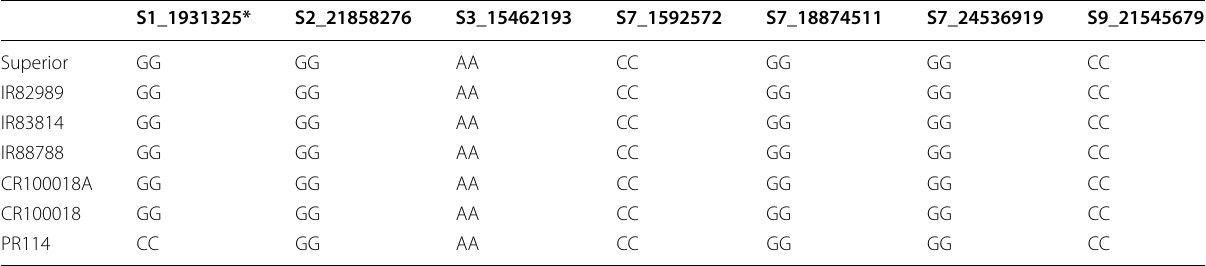
Table 7 The list of O. rufipogon accessions possessing combination of superior alleles at significant SNP positions associated with CT where SNPs marked with * represent alleles absent in indica cultivars